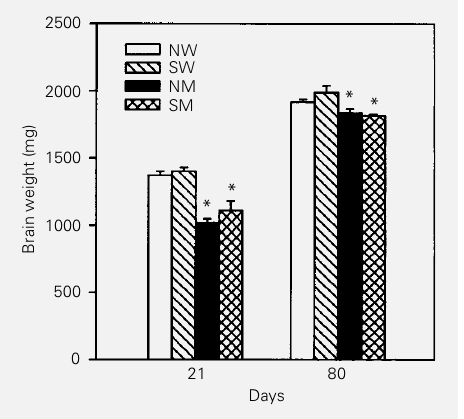
Figure 1 - Brain weight of pups at 21 and 80 days of age. The vertical bars indicate the SEM of 3 rats. NW, Non-stimulated well- nourished; SW, stimulated well- nourished; NM, non-stimulated malnourished; SM, stimulated malnourished. *P<0.05 com- pared to well-nourished groups of the same age (ANOVA fol- lowed by Newman-Keuls